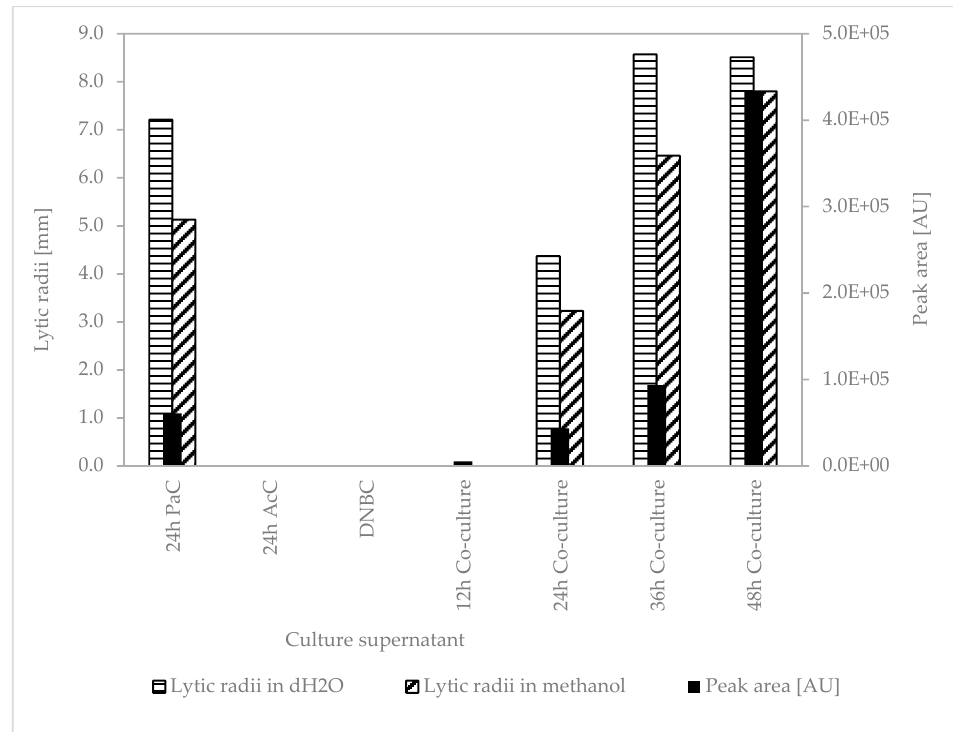
Figure 4. Peak areas measured by liquid chromatography coupled with tandem mass spectrometry of PP1 in culture supernatants compared to antimicrobial (lytic) activity of PP1 in different culture supernatants of P. apiarius SBUG 1947 against A. citreus.